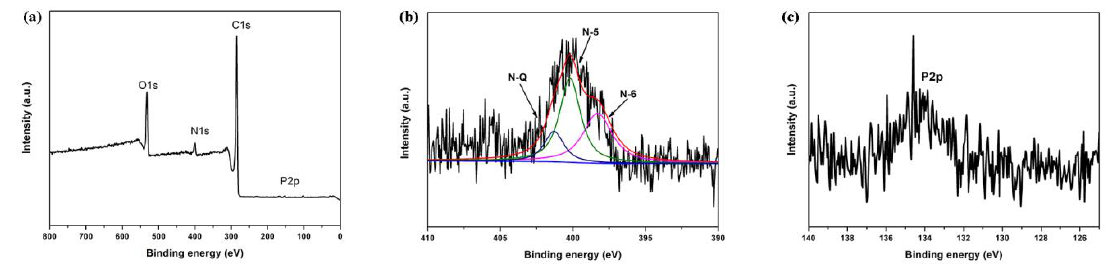
Figure 4. ( a ) XPS pattern; ( b ) high-resolution spectra for N1s and ( c ) spectra of P2p of ACF-10.3% PDPP. Table 2. XPS analysis of ACF-10.3% PDPP sample and corresponding relative contents of nitrogen and phosphorus species from core level XPS spectra.